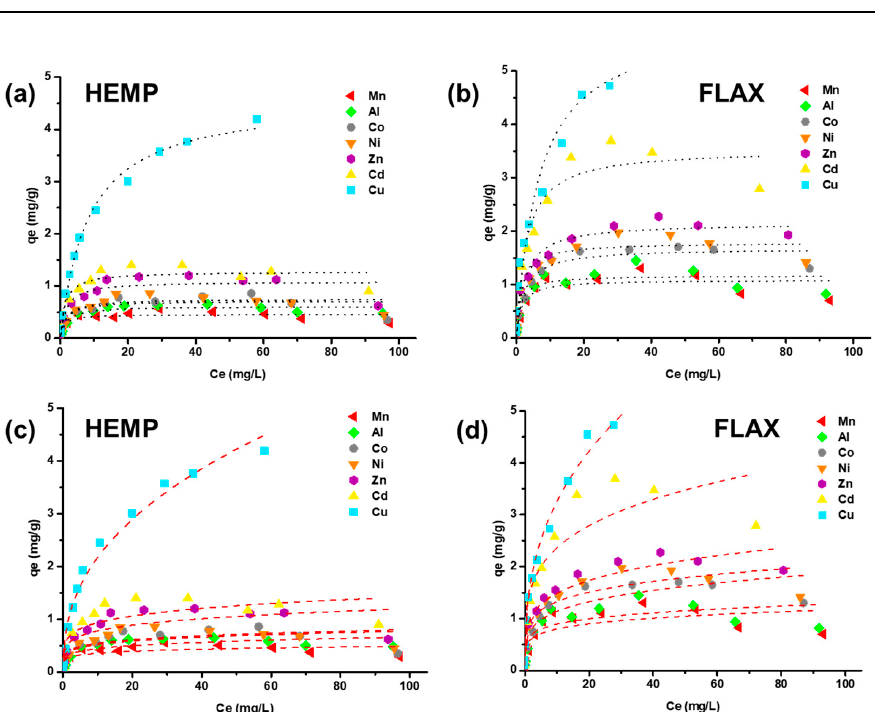
Figure 7. Comparison of Langmuir ( a , b ) and Freundlich ( c , d ) isotherms for 7 metals’ (Mn, Al, Co, Ni, Zn, Cd, Cu) adsorption onto hemp- and flax-based Table 2. Summary of the Langmuir and Freundlich isotherm constants and comparison of linear regression coefficients of determination (R 2 ) and chi-square test statistics ( χ 2 ).